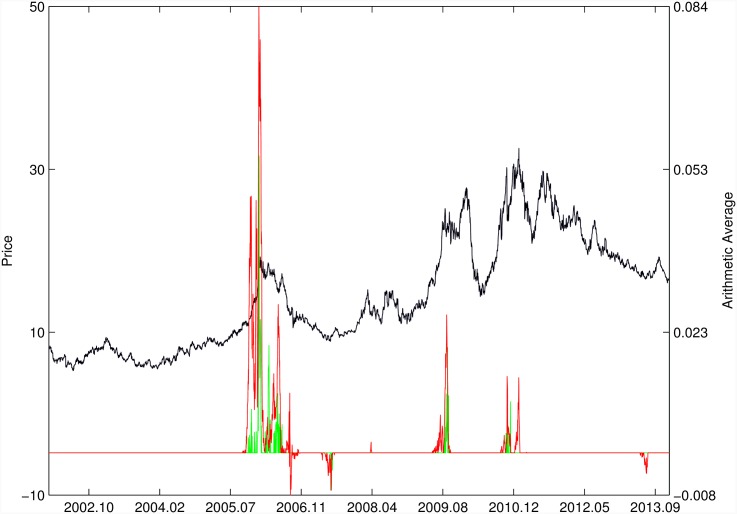
Sugar price.Same as Fig 10.